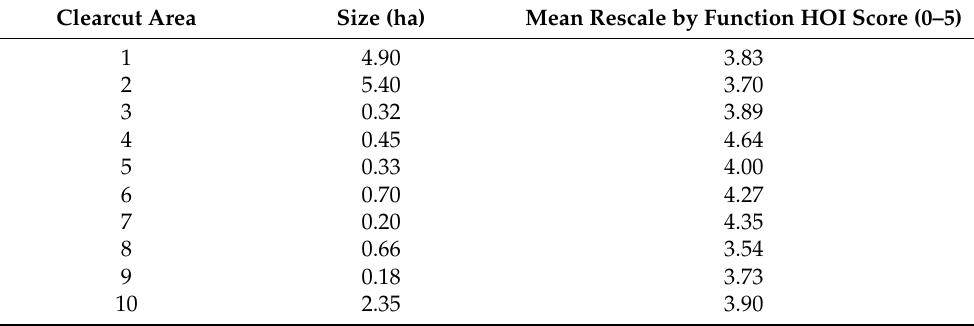
Table 5. Results of the mean HOI scores for 10 selected clear-cut harvesting areas in